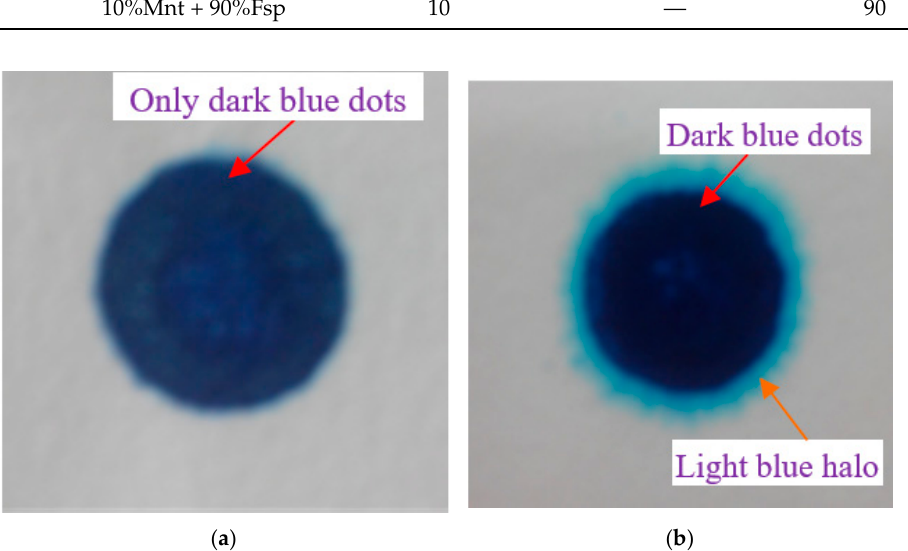
Figure 1. Determination of testing end. ( a ) Titration process; ( b ) titration end point. Average values were obtained twice for each sample. Due to the large specific surface area of montmorillonite and the amount of methylene blue solution required for the test, 5–10 g was determined to be an appropriate amount of soil for samples containing montmorillonite, and 30 g for soil samples without montmorillonite. The formula for calculating the specific surface area (SSA) of soils by methylene blue method is shown as follows: